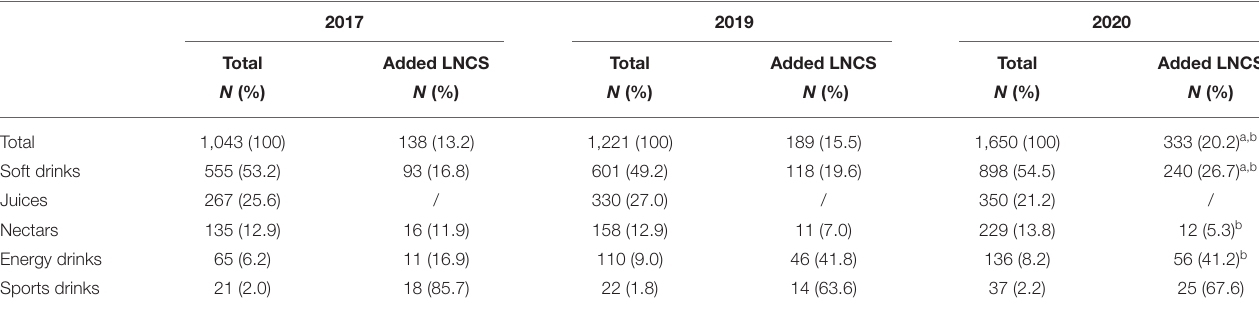
TABLE 1 | Sample description and availability of non-alcoholic beverages with added low- and/or no-calorie sweeteners (LNCS) in the Slovenian food supply in 2017, 2019, and